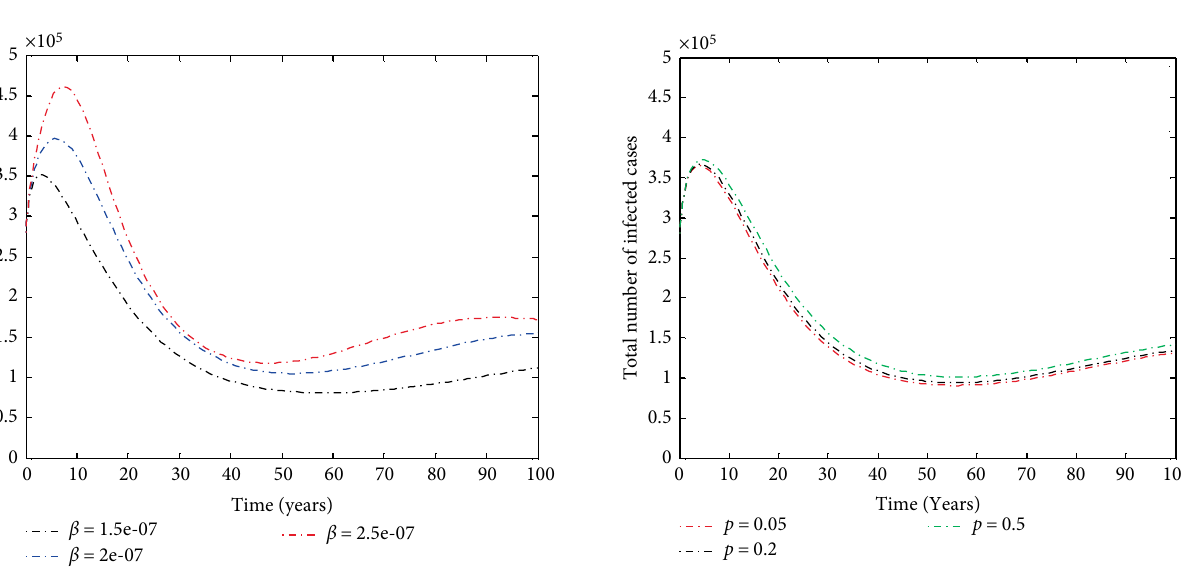
Figure 6: The effect of treatment failure rate on the number of infected class.